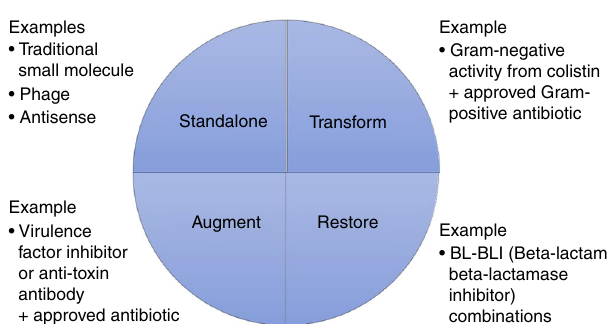
Fig. 1 STAR: The four novel product categories. Both traditional and non-